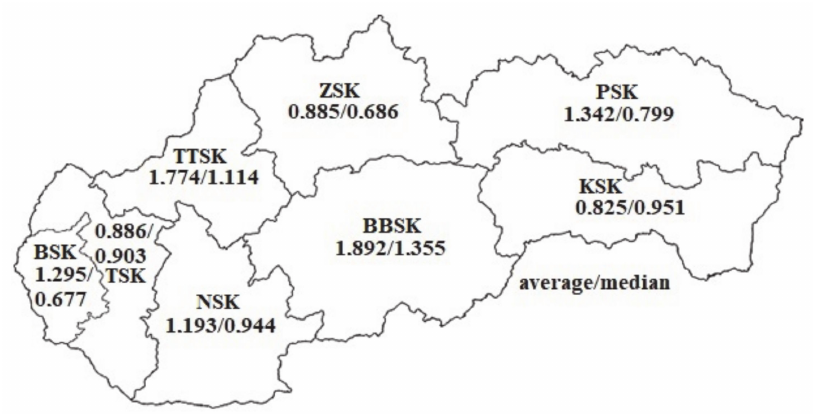
Figure 12. Spatial distribution of results at the level of individual regions—businesses. Legend: BSK— Bratislava region, TSK—Trnava region, TTSK—Trenˇc í n region, NSK—Nitra region, ZSK—Žilina region, BBSK—Bansk á Bystrica region, PSK—Prešov region, KSK—Košice